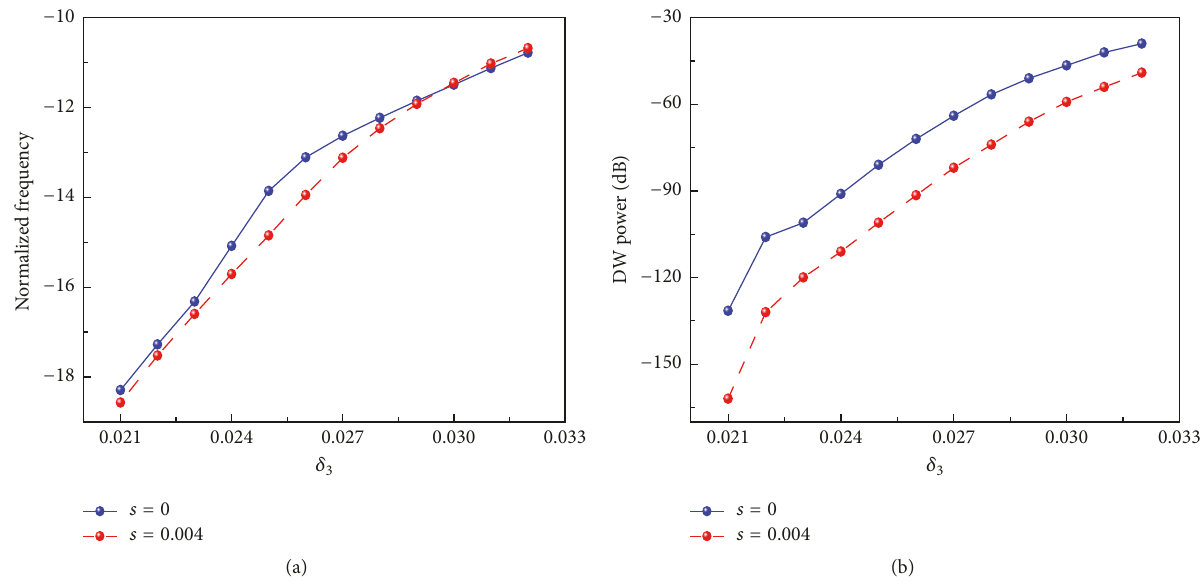
Figure 2: Central frequency (a) and relative average intensity (b) of the red-shift DW plotted as a function of TOD coefficient 𝛿 3 , where 𝑠 = 0 (blue filled circles lines) and 𝑠 = 0.004 (red dashed circles